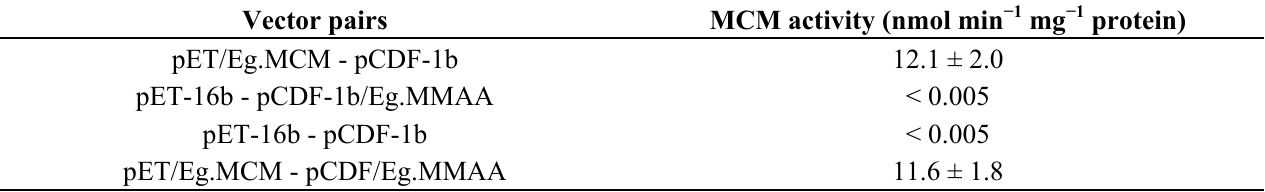
Table 1. MCM activity in E. coli expressing MCM or MMAA together or